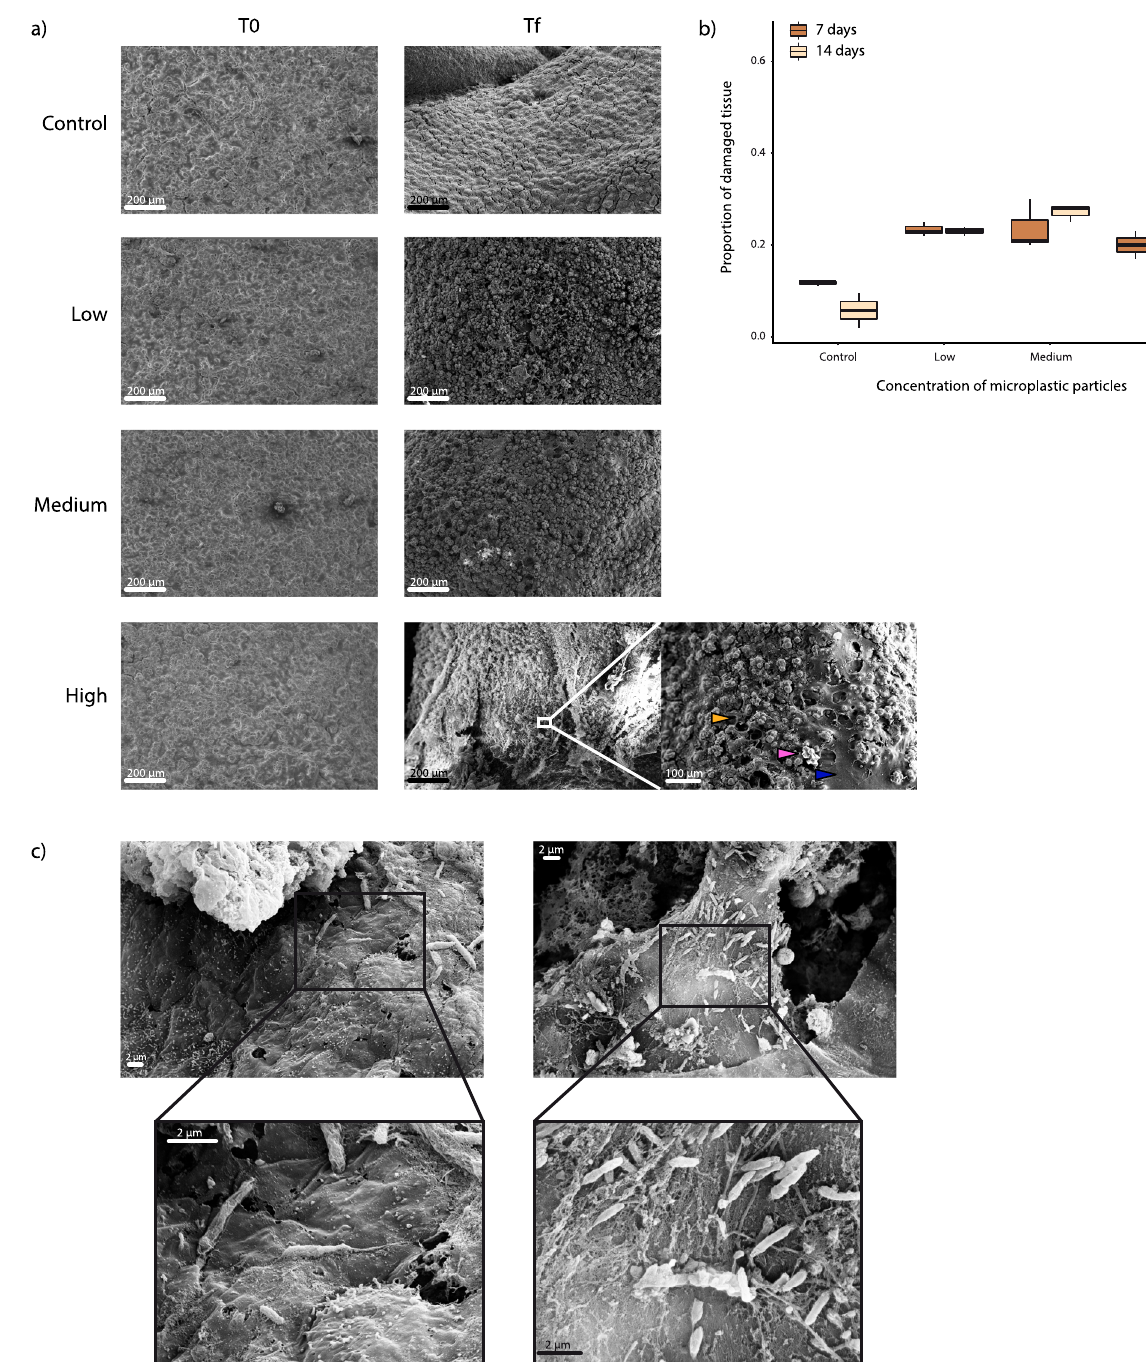
Fig. 4 SEM images of tissue damage of C. rubrum exposed to different microplastic concentrations and injured coral tissue colonized by bacterial cells. a SEM images of the coral tissue exposed and not exposed to microplastics (Control) at the beginning (t0) and at the end of the experiment (tf, i.e., 14 days after the start of the experiment) and a close-up of coral tissues exposed to high concentration of microplastic particles at the end of the experiment (the blue arrow indicates damaged tissue; the yellow arrow indicates healthy tissue and the fuchsia arrow indicates one of the sclerites). Size scales are provided for each picture. b Average proportion of damaged tissue area of corals exposed to different microplastic concentrations after 7 and 14 days of treatment. At the start of the experiment (t0), tissue damage was not detectable in all specimens. Data are represented as mean ± standard deviation ( n = 3). c On the left, SEM image of the coenenchyma without lesions in C. rubrum exposed to high concentration of microplastic particles and relative close-up of the tissue with evidence of the bacillus-like cells colonizing the tissue; on the right, coral tissue with lesions densely colonized by bacillus-like